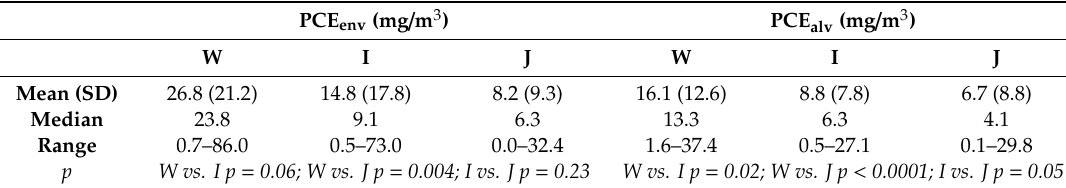
Table 2. Perchloroethylene environmental concentrations measured with personal samplers (PCE env ), 8 hours TWA, and PCE concentration in end-shift alveolar air (PCE alv ) in the sample of dry cleaners classified according to their working tasks as “washers”, “ironers” and “jolly”.